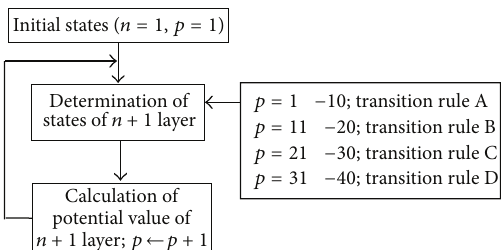
Figure 6: Calculation steps. The setting of each structural unit depends on the states of the three units below. Transition rules are a set of 8-bit binary numbers memorized as the design information in advance.Furthermore,theuppermostunithasthepotentialnumber of the lower units plus one. In addition, the transition rules changed every ten